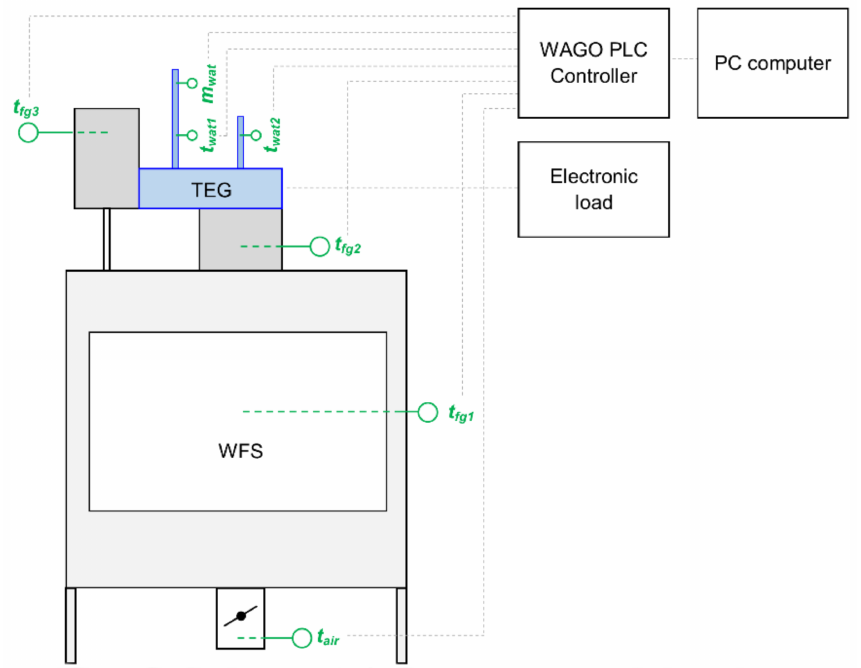
Figure 4. The general scheme of the experimental